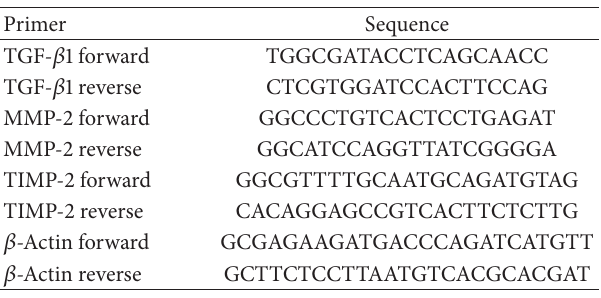
Table 1: Primer sequences used for the amplification of each target DNA.